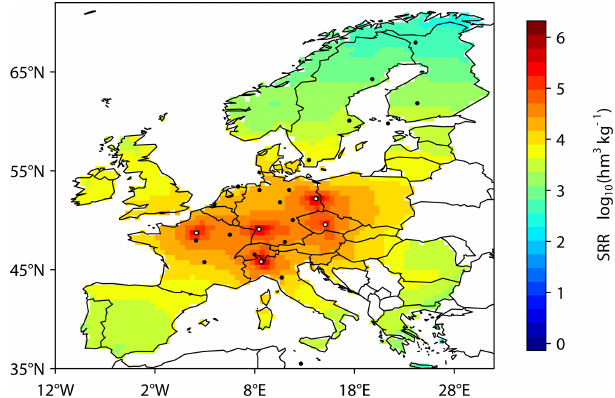
Figure 2. Map of annual mean CH 4 emissions (units of kgm − 2 yr − 1 ) plotted with a logarithmic (base of 2) colour